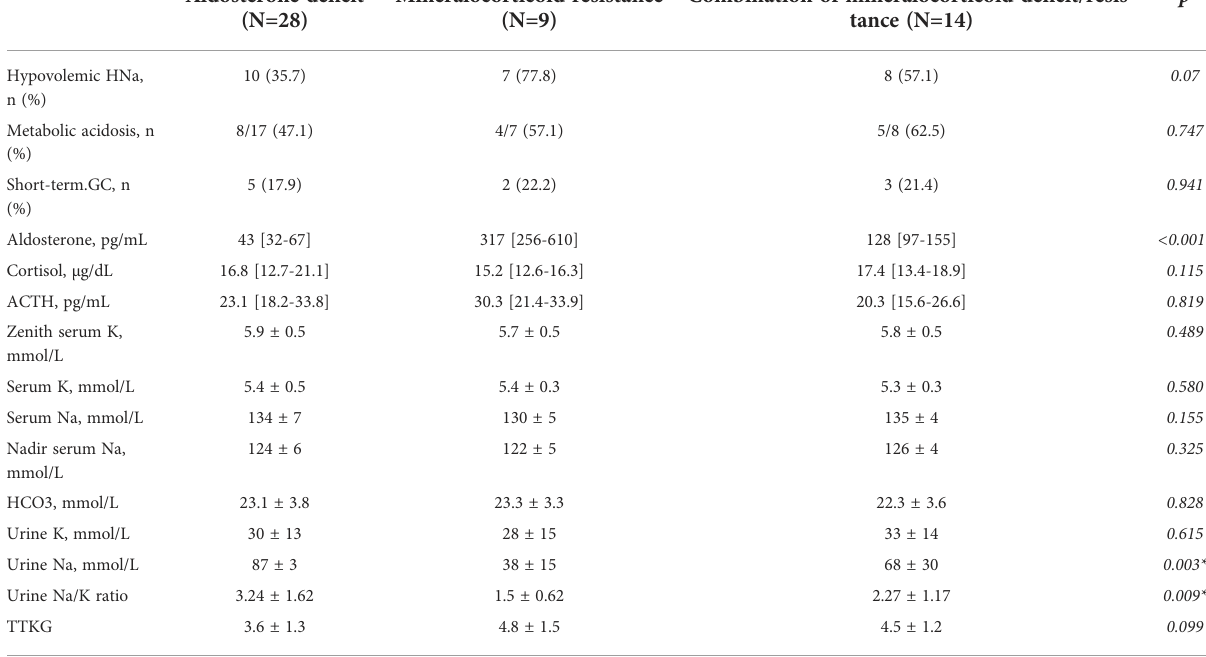
TABLE 5 Clinical/Biochemical characteristics of the types of acquired hypoaldosteronism